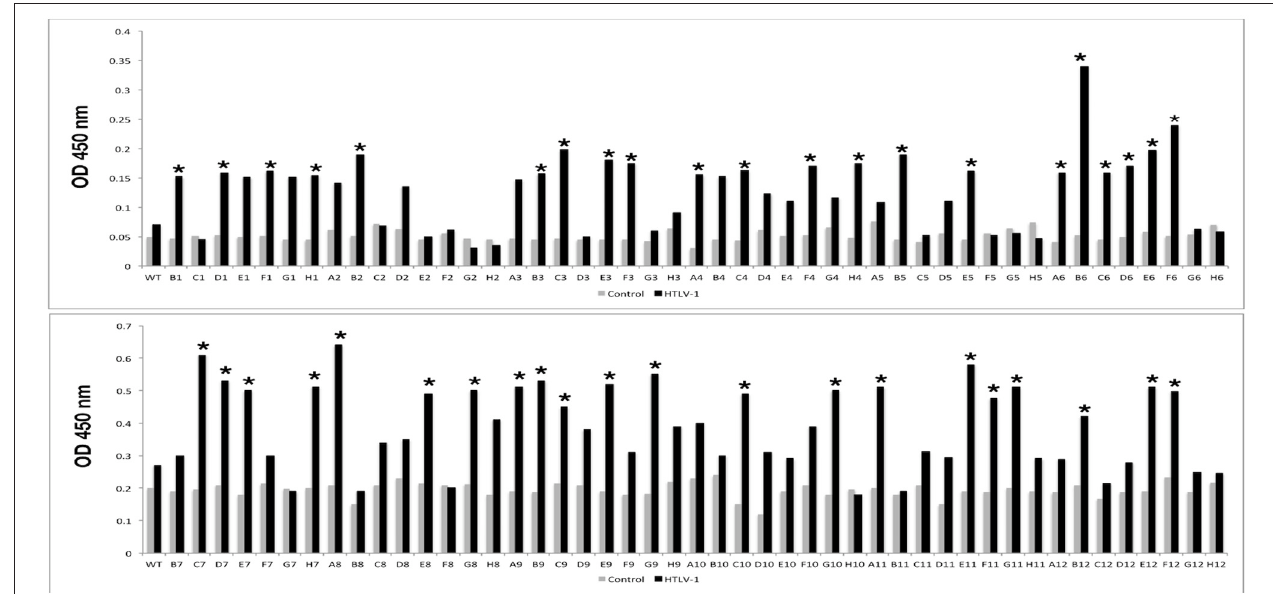
FIGURE 1 | Immunoreactivities of peptides selected by phage display in the Phage-ELISA assay. Peptides that showed significantly higher absorbance when compared to the control (*) were tested against pool serum samples from individuals with HTLV-1 and the control group. WT: wild type phage (phage that does not express any exogenous